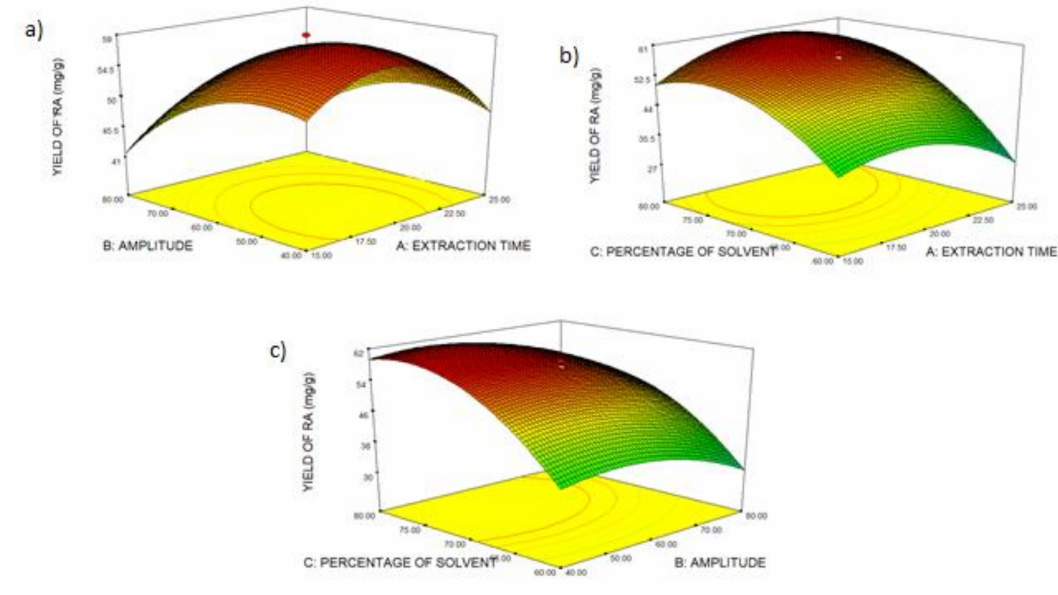
Figure 5. Surface plot of the yield of rosmarinic acid: ( a ) extraction time and amplitude, ( b ) extraction time and percentage of solvent, ( c ) amplitude and percentage of solvent.